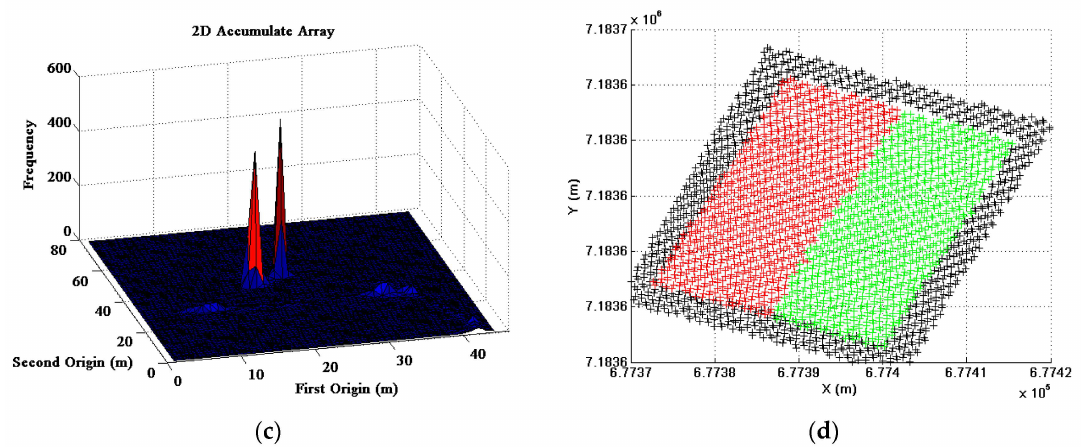
Figure 8. Aggregation of points with similar attributes: ( a ) the digital image; ( b ) the Digital Surface Models over the area of interest; ( c ) the accumulator array; and ( d ) the segmented